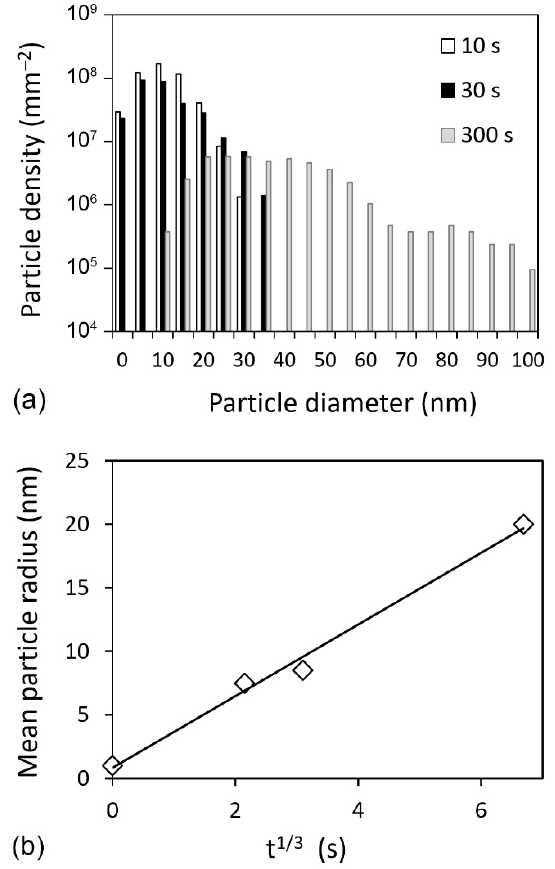
Figure 3. ( a ) Histograms of the particle size distribution in annealed conditions, ( b ) plot of the mean particle radius vs. annealing time t 1/3 .